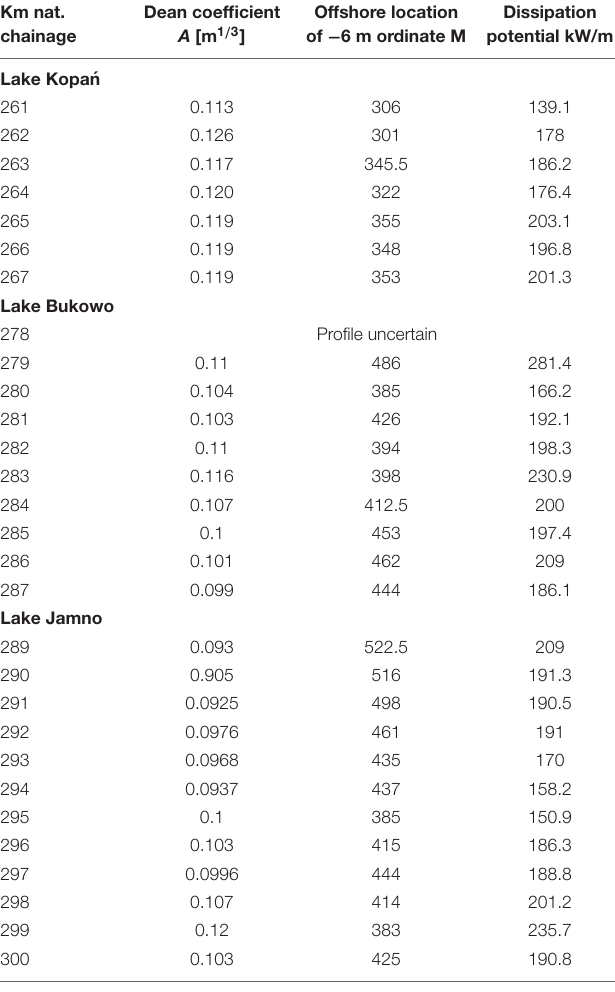
TABLE 3 | Wave energy dissipation for seabed survey 2005-6 using Dean function concept. Km nat.